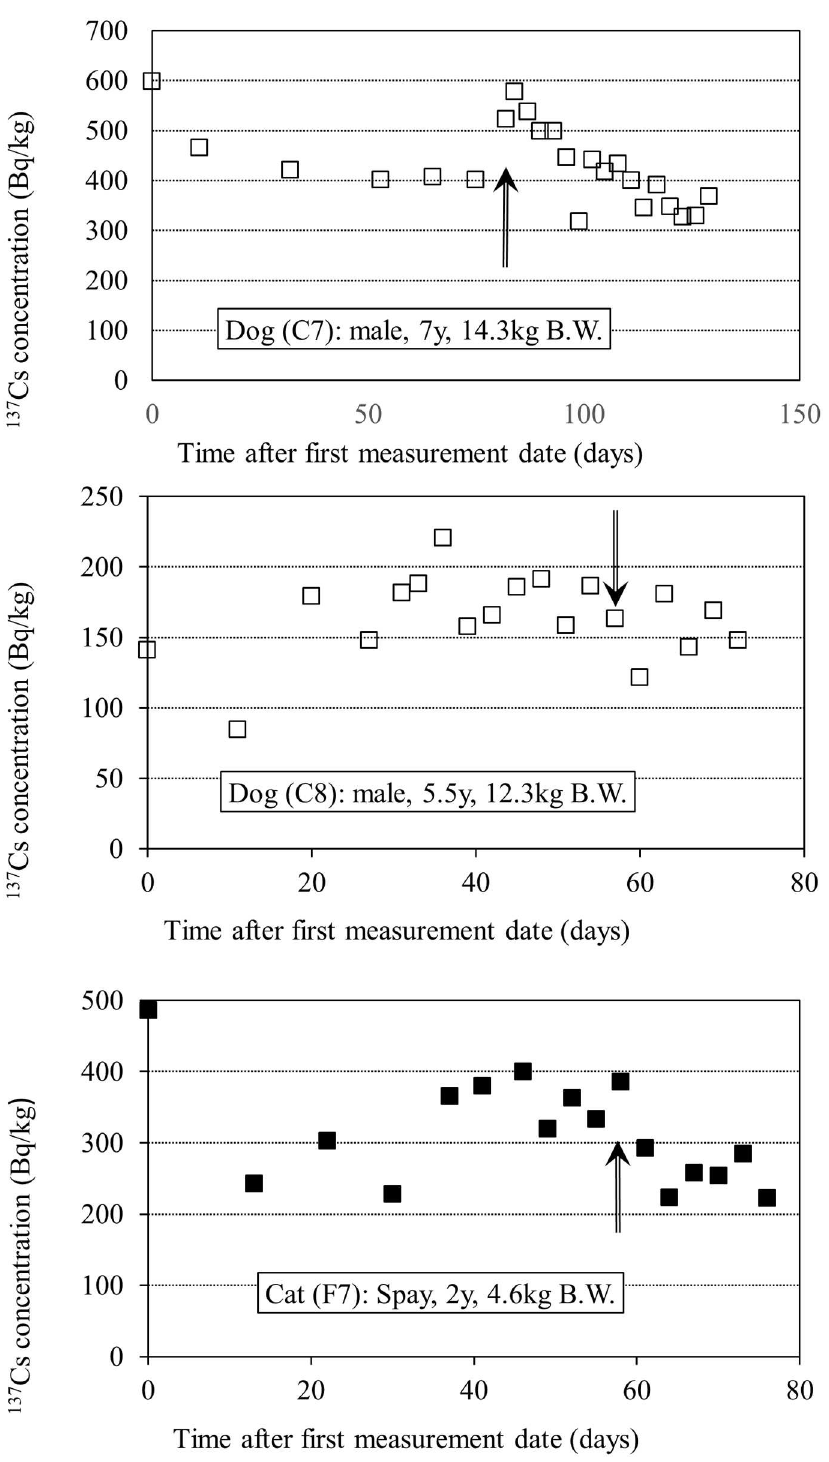
Fig 2. Observation of radiocesium decay after intervention. In these cases it was not observed radiocesium decay, so the animals’bodies were washedagain. The arrows indicate the point at which the animalswere shampooed. C7 moved aroundin the cage a lot duringthe measurement, so its movement was limited by using a smaller cage and pillows.